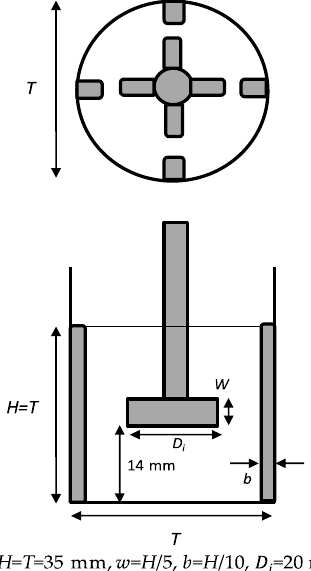
Figure 2. Mixing vessel and stirrer employed in the present study.